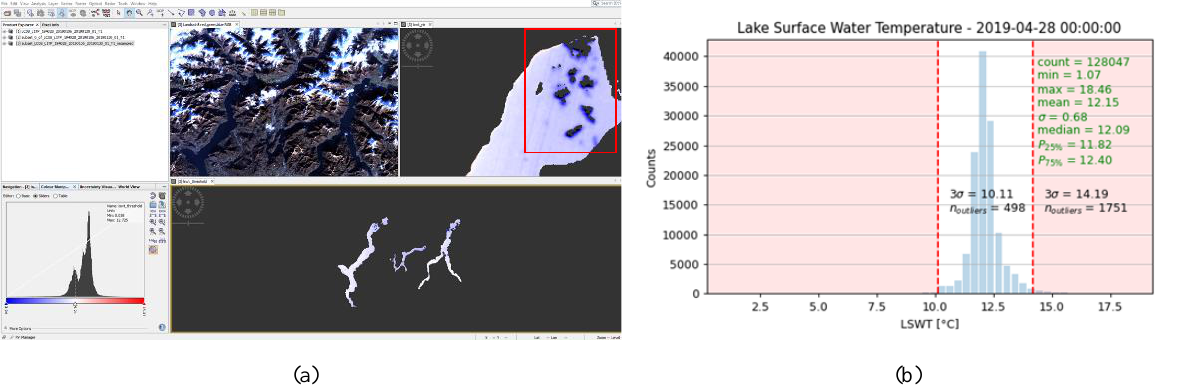
Figure 6. Cloud coverage effects on LSWT WQP map. (a) Visual inspection in SNAP of LSWT anomalies of due to pixels surrounding cloud coverage. (b) Histogram and statistics of the LSWT map